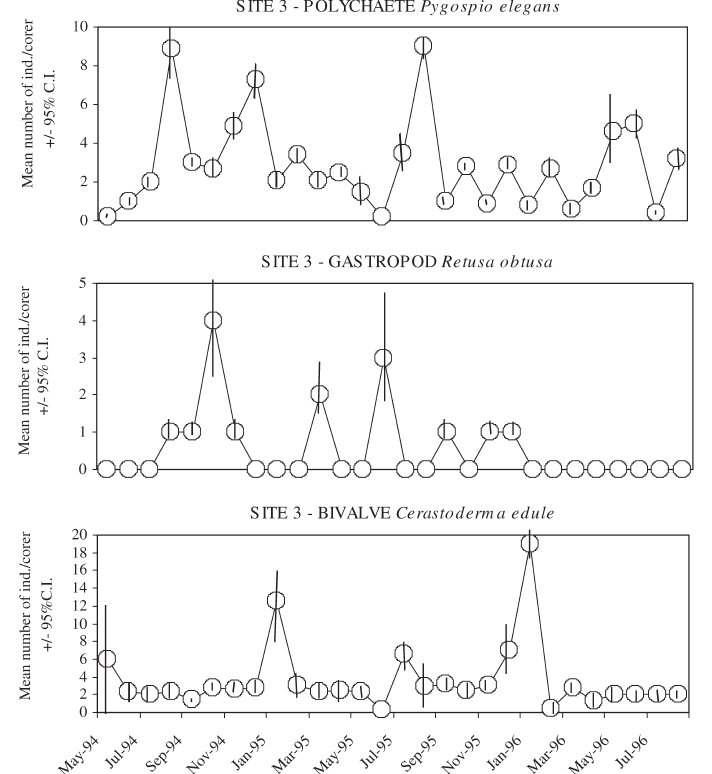
Fig . 7. – Mean abundance of some of the most conspicuous species at Site 3, Culbin Sands lagoon, NE Scotland during 1994-1996 (confidence intervals, C.I., when not fully represented, can be obtained from the symmetrical